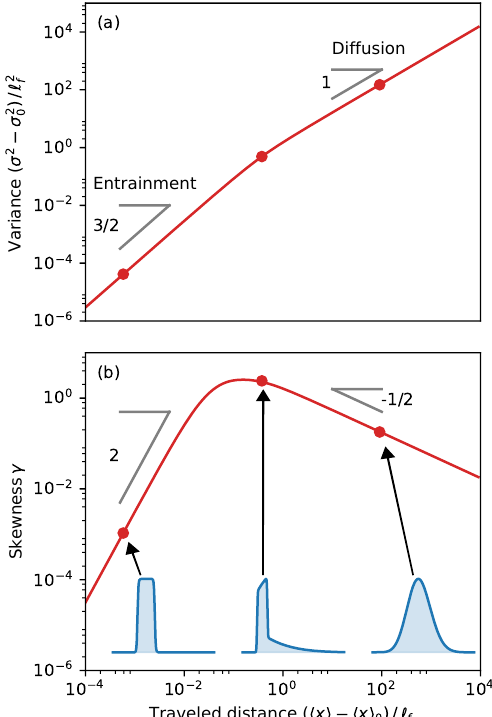
Figure 4. (a) Variance and (b) skewness of a plume of tracers as a function of traveled distance ( α = 0.1). These three quantities are calculated from Eqs. (28), (33), and (38). Inset: concentration pro- files (blue) illustrating the shape of the plume during the entrain- ment regime (left), at the transition between the entrainment and the diffusive regime (center), and in the diffusive regime